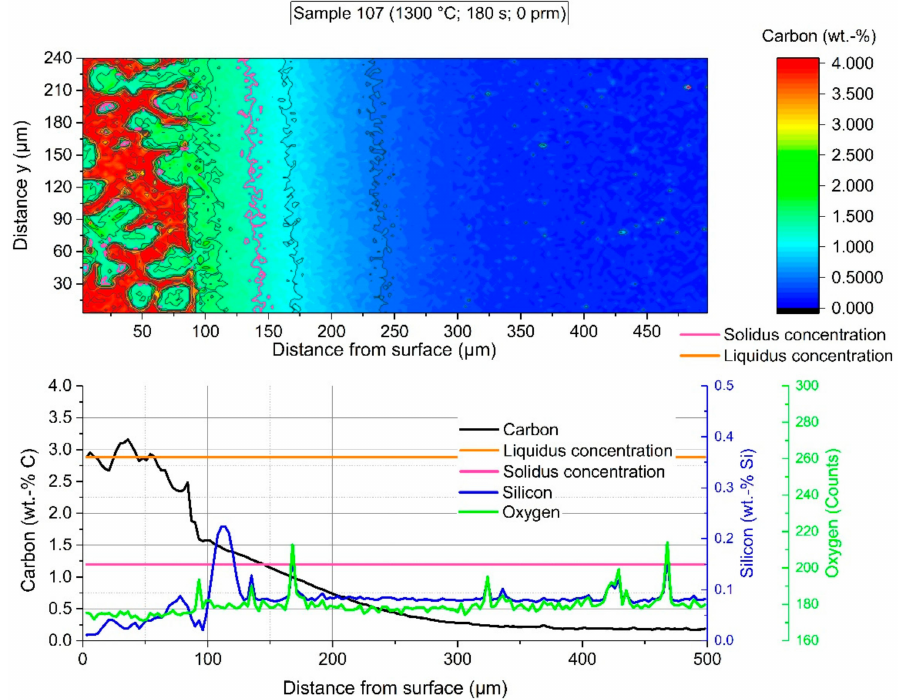
Figure 13. EPMA-measured carbon distribution of sample 107 with an immersion time of 180 s at 1300 ◦ C equilibrium